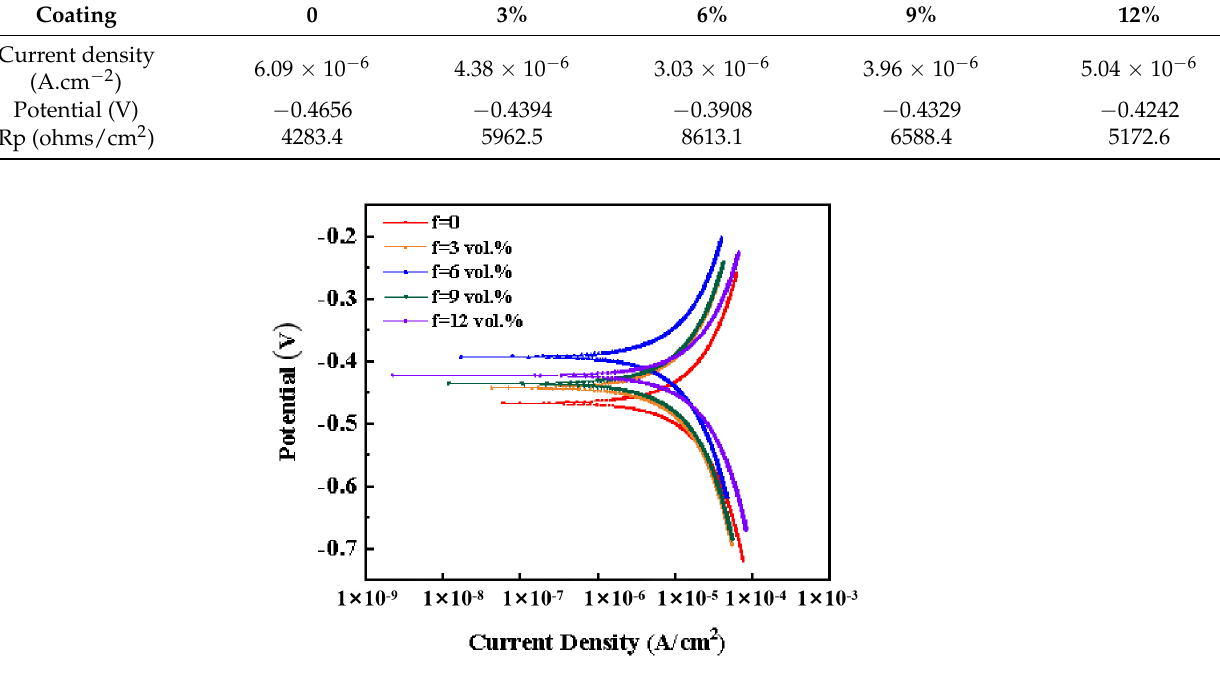
Figure 9. Potentiodynamic polarisation curves of the coatings in a 3.5 wt.% NaCl solution. Table 4. Corrosion potential, polarization resistance, and polarization current density of the coat-